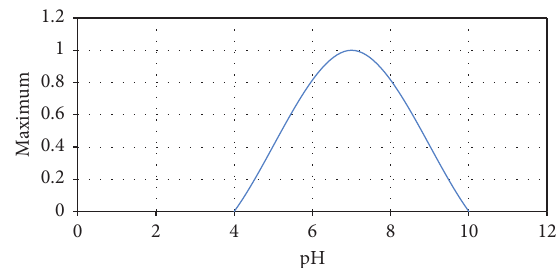
Figure 7: A plot for the growth of aquatic organisms as a function of